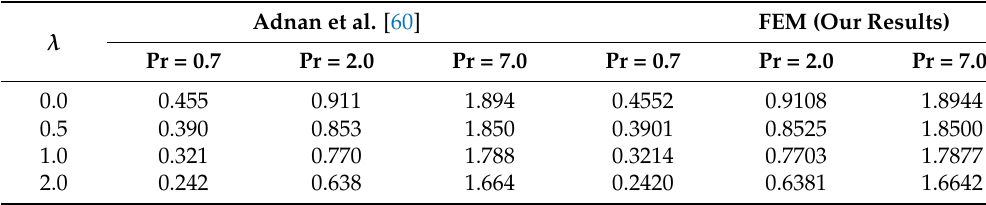
Table 5. − θ (cid:48) ( 0 ) value along with diverse values of λ at ζ = 1 when remaining parameters are